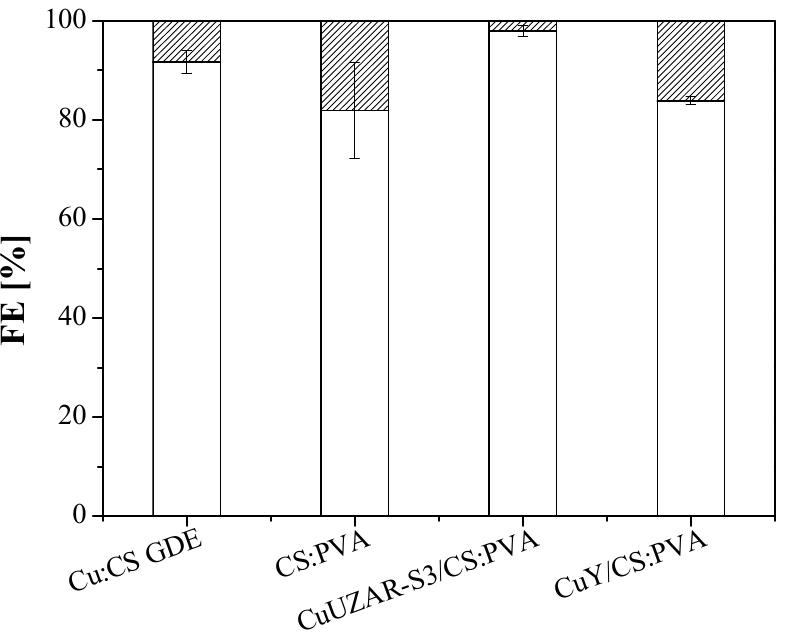
Figure 4. FE of ethylene (blank) and hydrogen (striped) obtained at 10 mA cm − 2 with the three MCEs proposed in this study. The results obtained with the uncoated Cu:CS GDE are also shown for comparison. The Sustainion AEM was the compartment separator. Table 3. Experimental results of the CO 2 R conversion to C 2 H 4 in MEA configuration with Cu-based membrane coated electrodes (MCEs) in 1 M